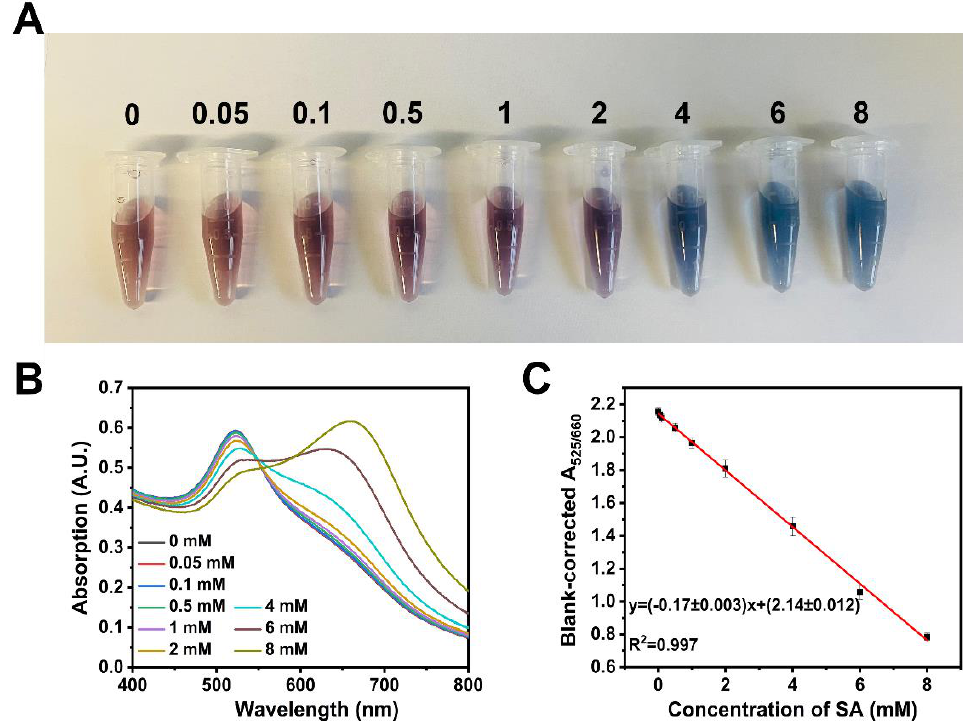
Figure 4. ( A ) Graph shows the color change by the different concentration of SA, ( B ) The UV–Vis absorption spectra of the 4-MPBA-AuNPs@PEG 400 sensing system in the presence of various concentrations of SA. ( C ) The linear calibration plot for SA detections based on the changes in absorption (A 525/660 ).